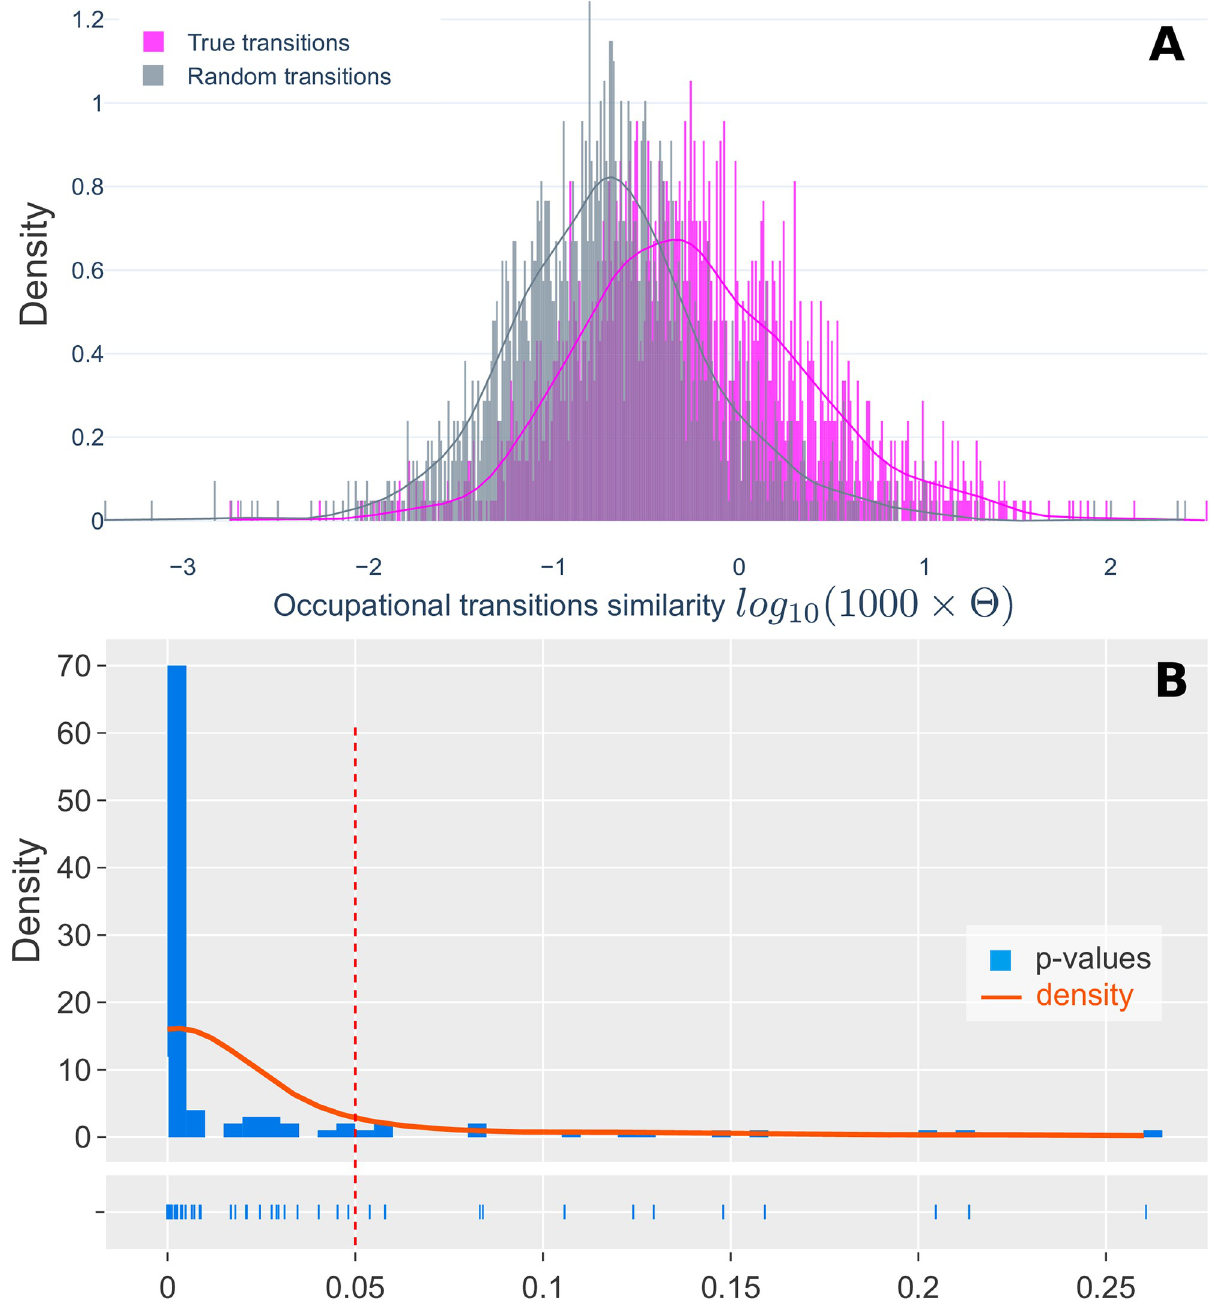
Fig 2. The Skills Space is statistically significant in representing job transitions. (A) The x-axis shows the log-transformed S KILLS S PACE distance for a ‘True’ sample of actual transitions (shown in magenta color) and a ‘Random’ sample of simulated transitions (shown in gray color). Each Random transition is paired with an Actual transition: it shares the same ‘source’ occupation as the Actual transition but the ‘target’ occupation is randomly selected and is different to the Actual observation. The difference between the two populations is statistically significant (paired t-test, t-statistic = 4.514, p-value = 6.535 × 10 − 6 , Cohen’s D effect size = 0.14). (B) We repeat the procedure 100 times: we generate 100 ‘Random’ populations, and we perform the statistical testing for each. The figure shows the histogram (density and rug plot) of the 100 obtained p-values, 87 of which are lower than 0.05.